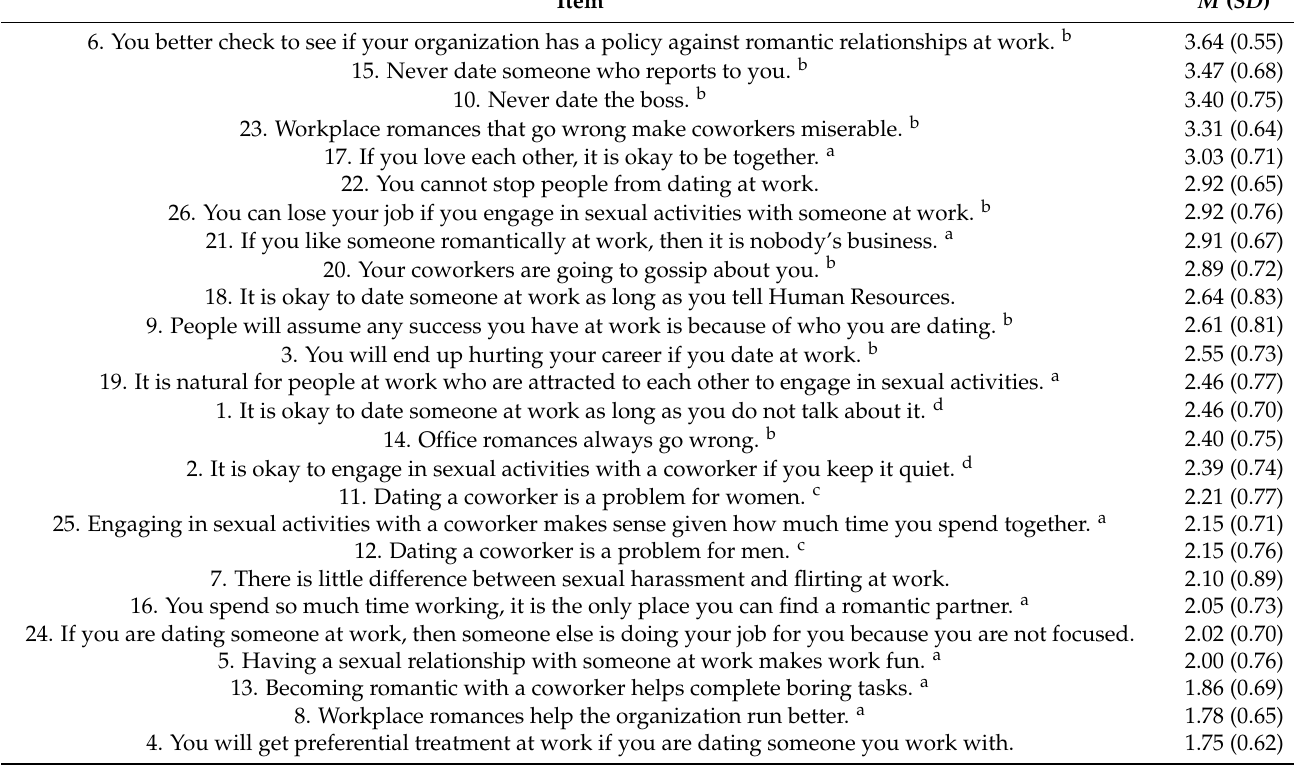
Table 2. Ranked advice messages about workplace romance.